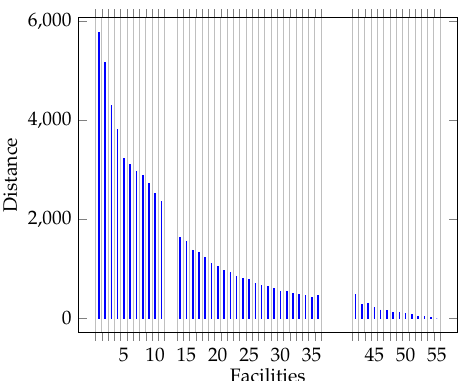
Figure 5. Computed Pareto set for the Swain dataset using genetic